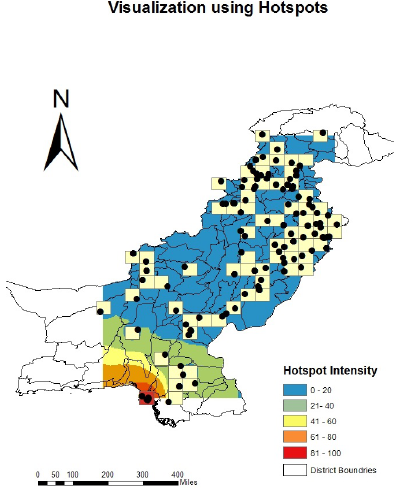
Figure 3. Visualization of crime cases on the basis of each crime type using